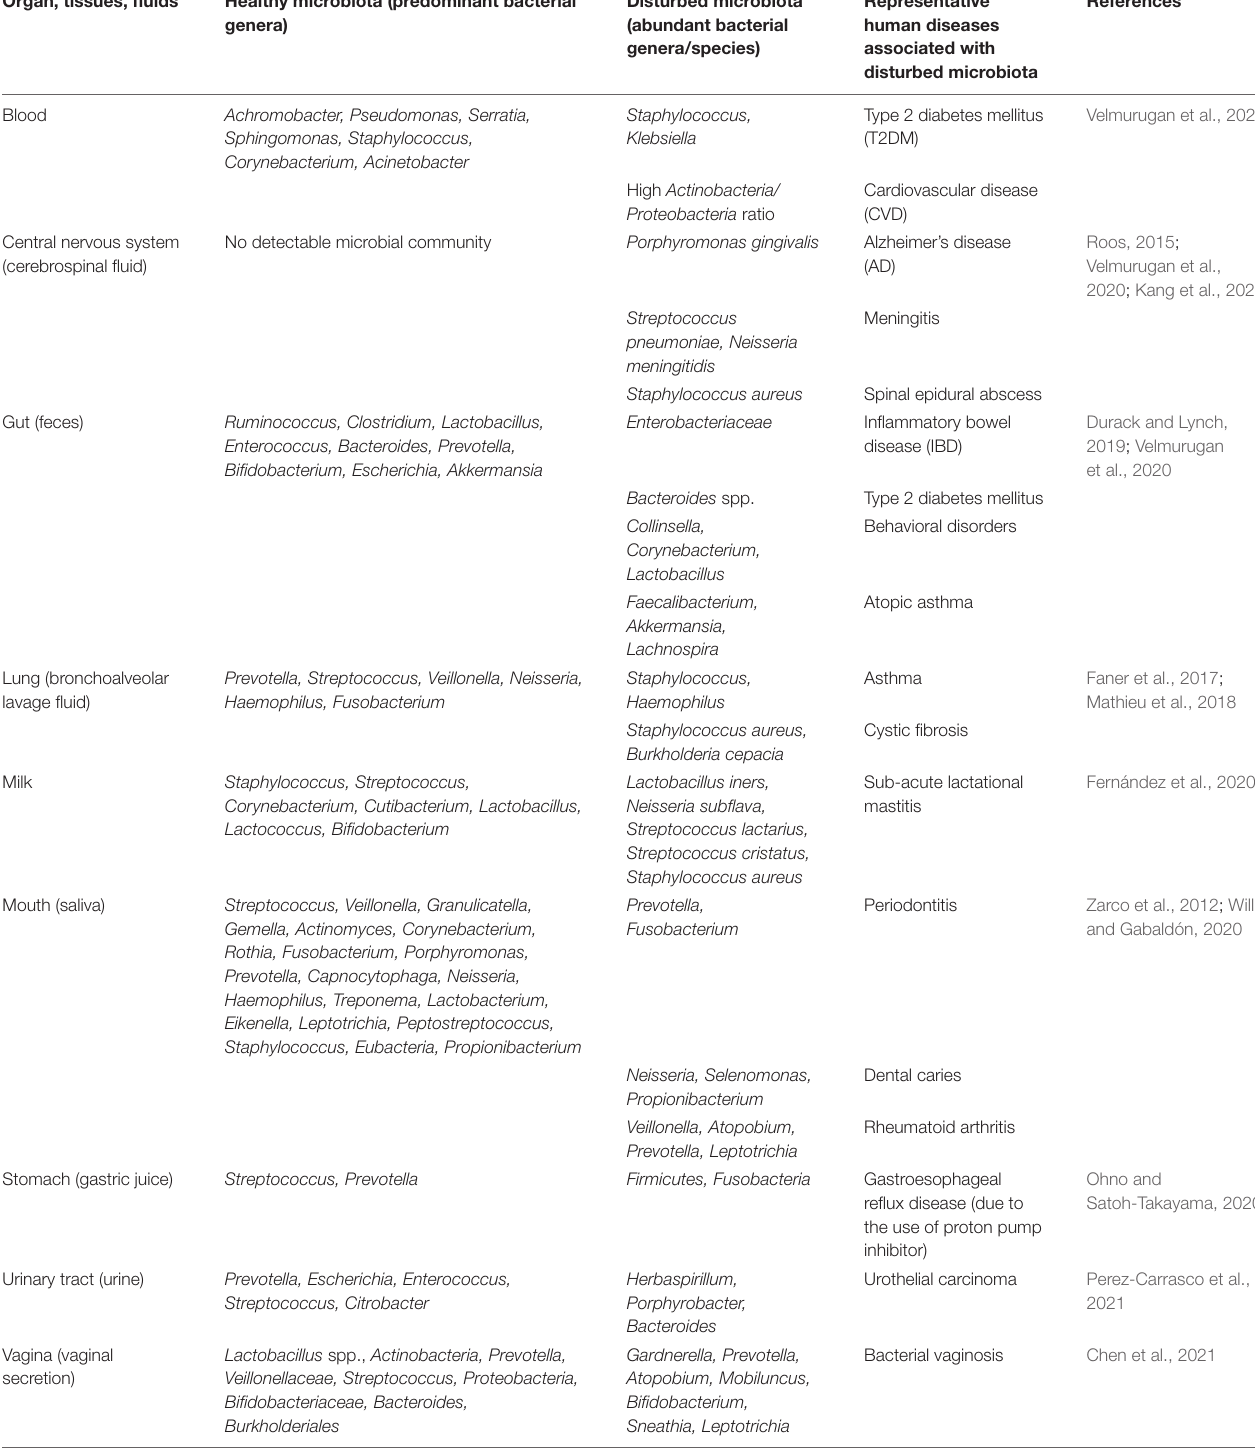
TABLE 1 | Comparison of healthy and disturbed microbiota that might contribute to the understanding of certain diseases from microbial perspectives. Organ, tissues,